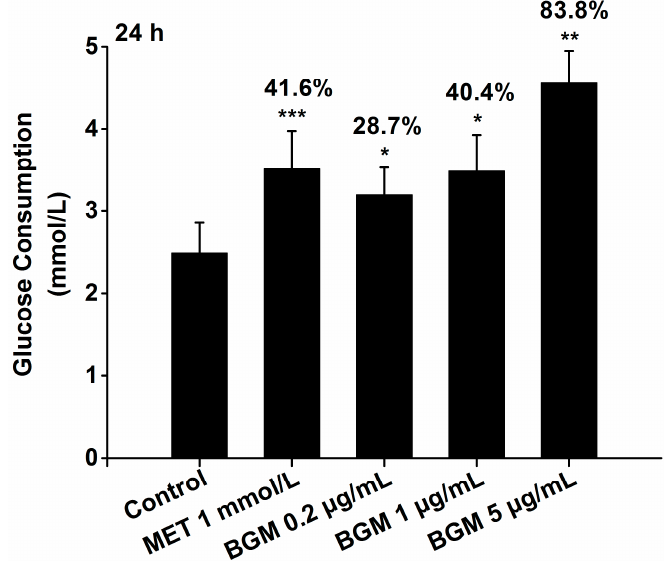
Figure 5. Effect of purified bergamottin (BGM) on glucose consumption after 24 h treatment in HepG2 cells. * p < 0.05, ** p < 0.01, *** p < 0.001, compared to the DMSO blank control. MET, metformin as a positive control.